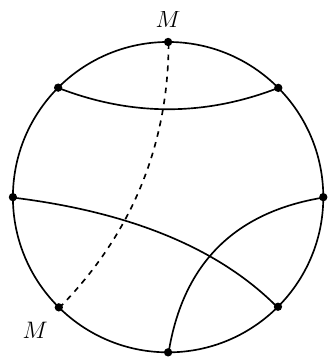
Figure 2. A chord diagram contributing to h tr MH 2 MH 4 i J . A chord connecting 2 M -operators is distinguished from the Hamiltonian chords, and is represented here by a dashed